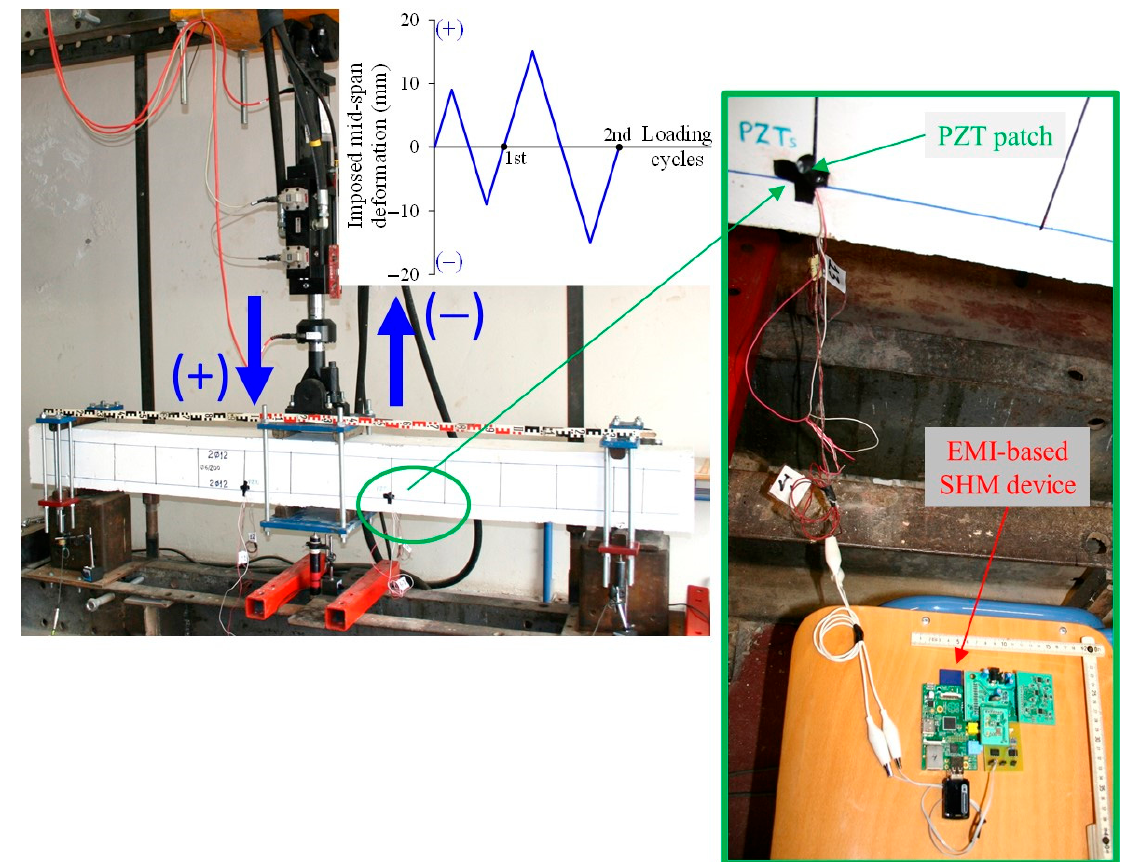
Figure 5. Test setup of the cyclic loading test, history and device of the developed SHM technique.